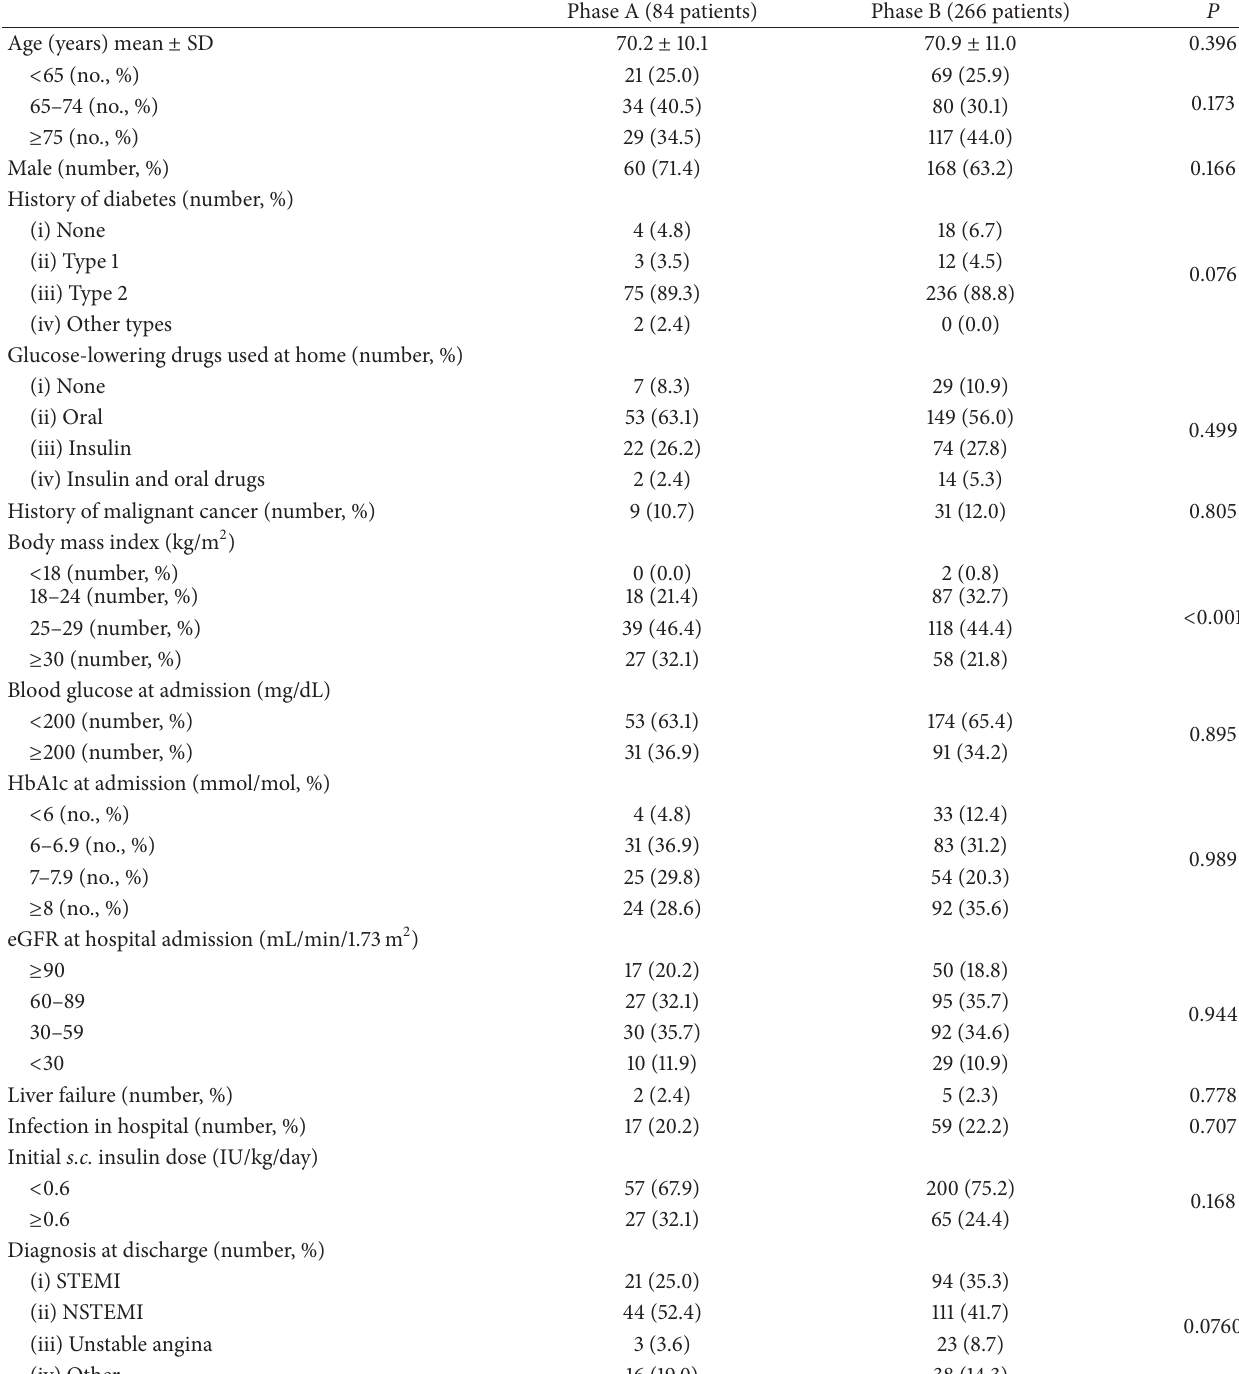
Table 1: Patients’ main